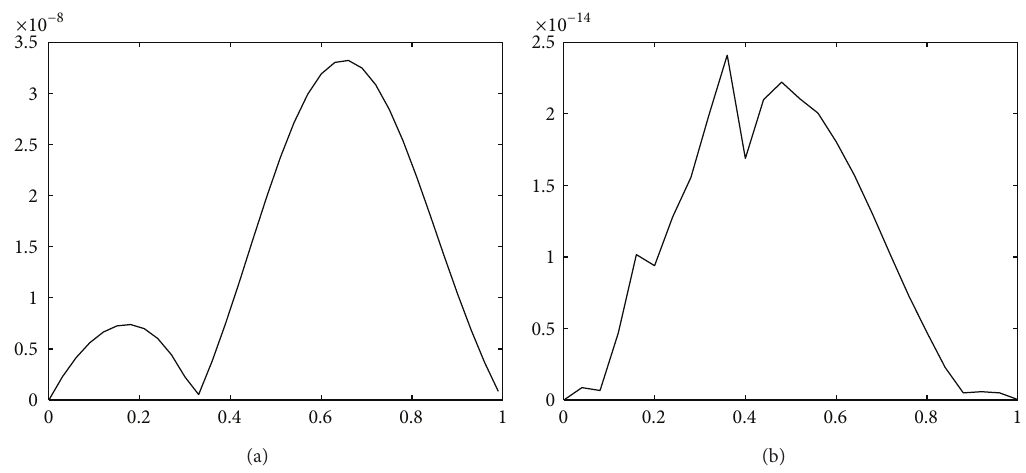
Figure 3: Error function of problem (64) for 𝑚 = 4 (a) and for 𝑚 = 8 (b).